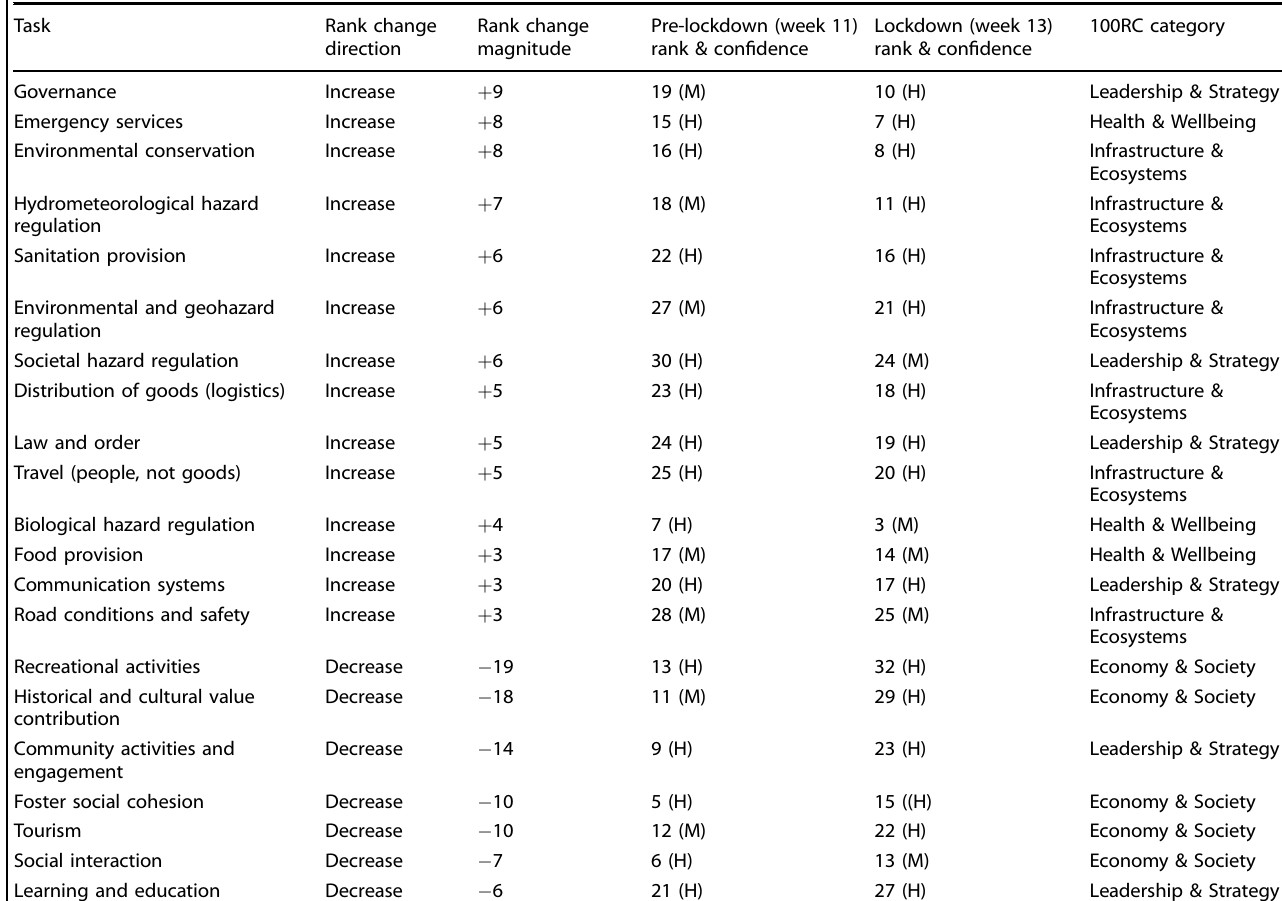
Table 2. Tasks with large magnitude rank changes which were robust to sensitivity analysis, between pre-lockdown and lockdown